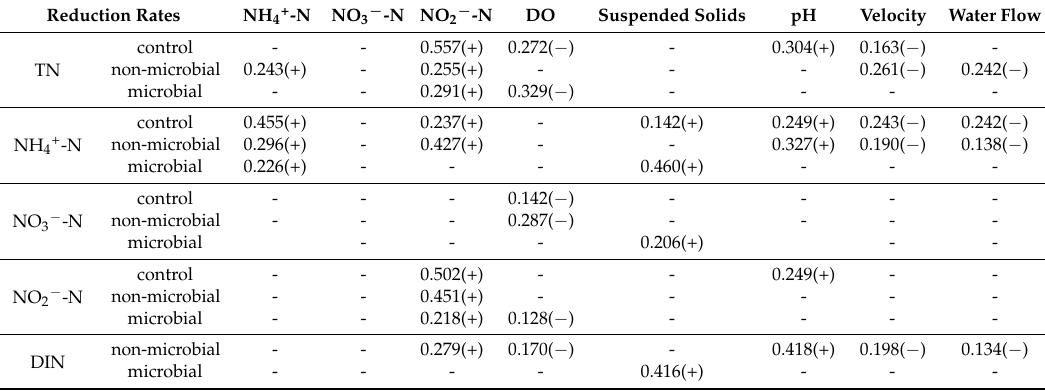
Table 3. Correlation coefficients between N reduction rates and environmental factors.